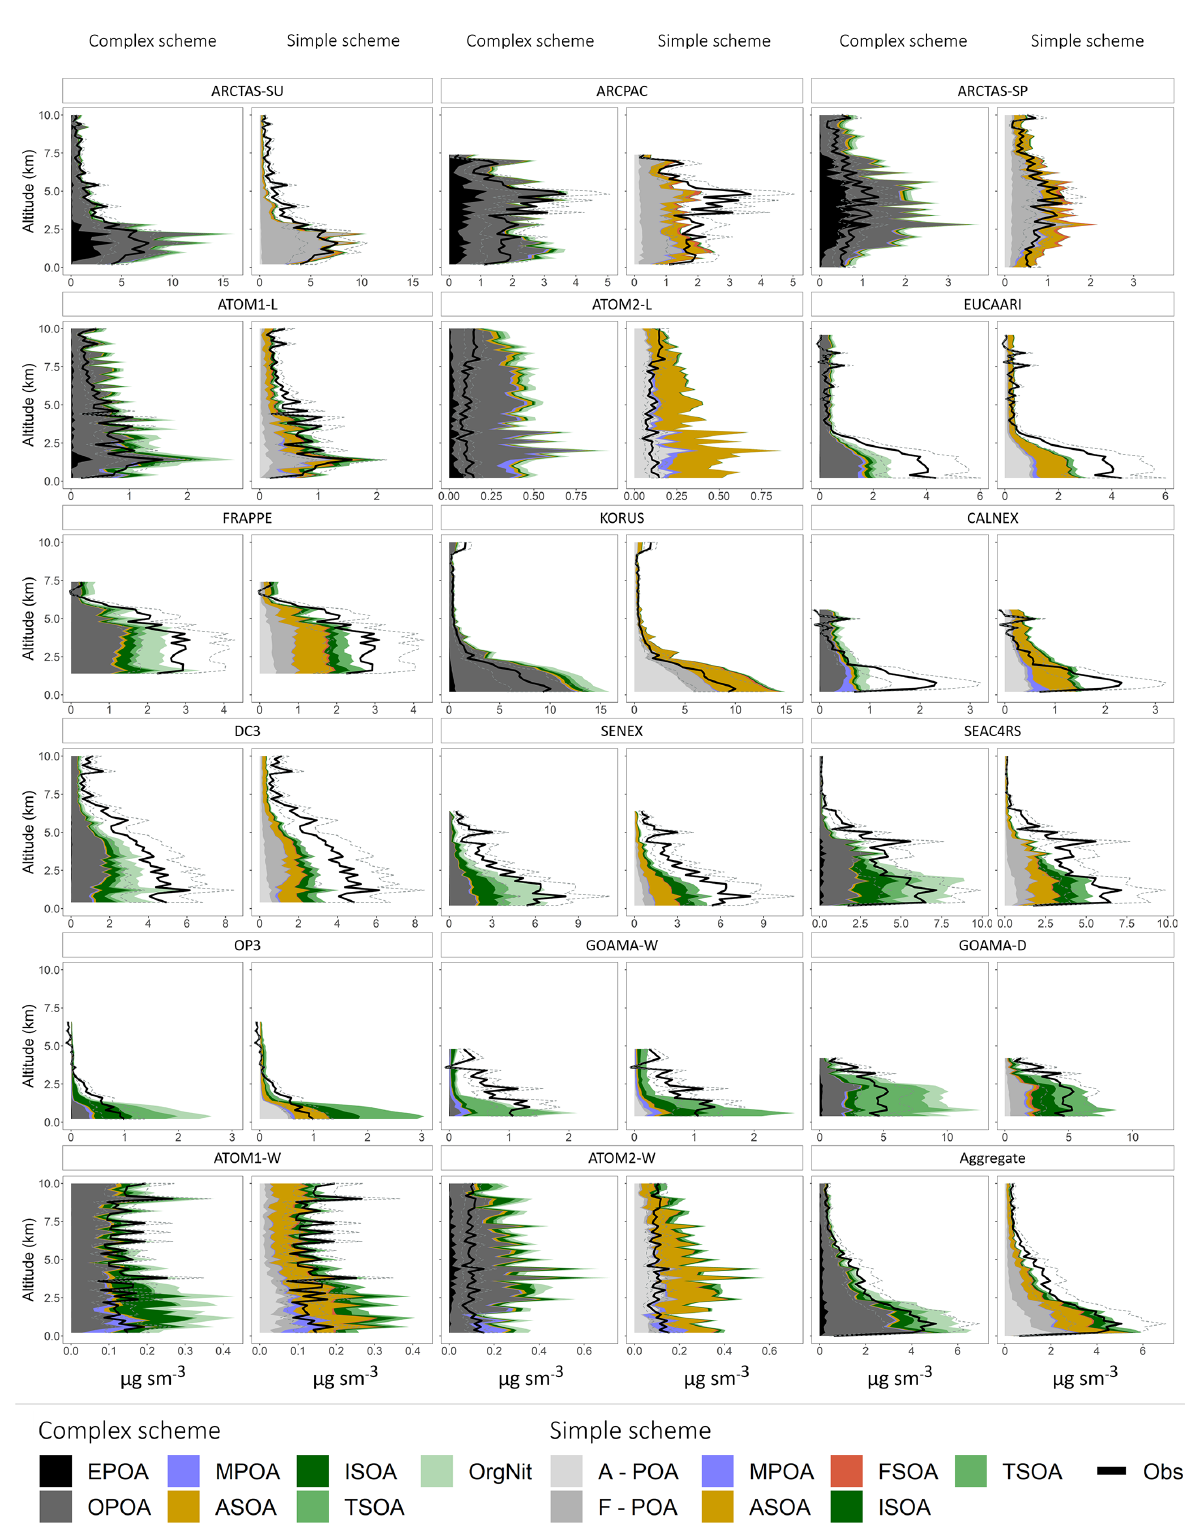
Figure 9. Mean vertical profiles (in kilometers) comparing the observed (black) and simulated (colored) OA mass concentrations across the different campaigns. The dashed lines represent the uncertainty in the observed OA mass loadings. The profiles are binned at 200m intervals. For the simple scheme, A-POA represents anthropogenic POA and F-POA represents pyrogenic POA. Refer to the text for other OA categories and details on model